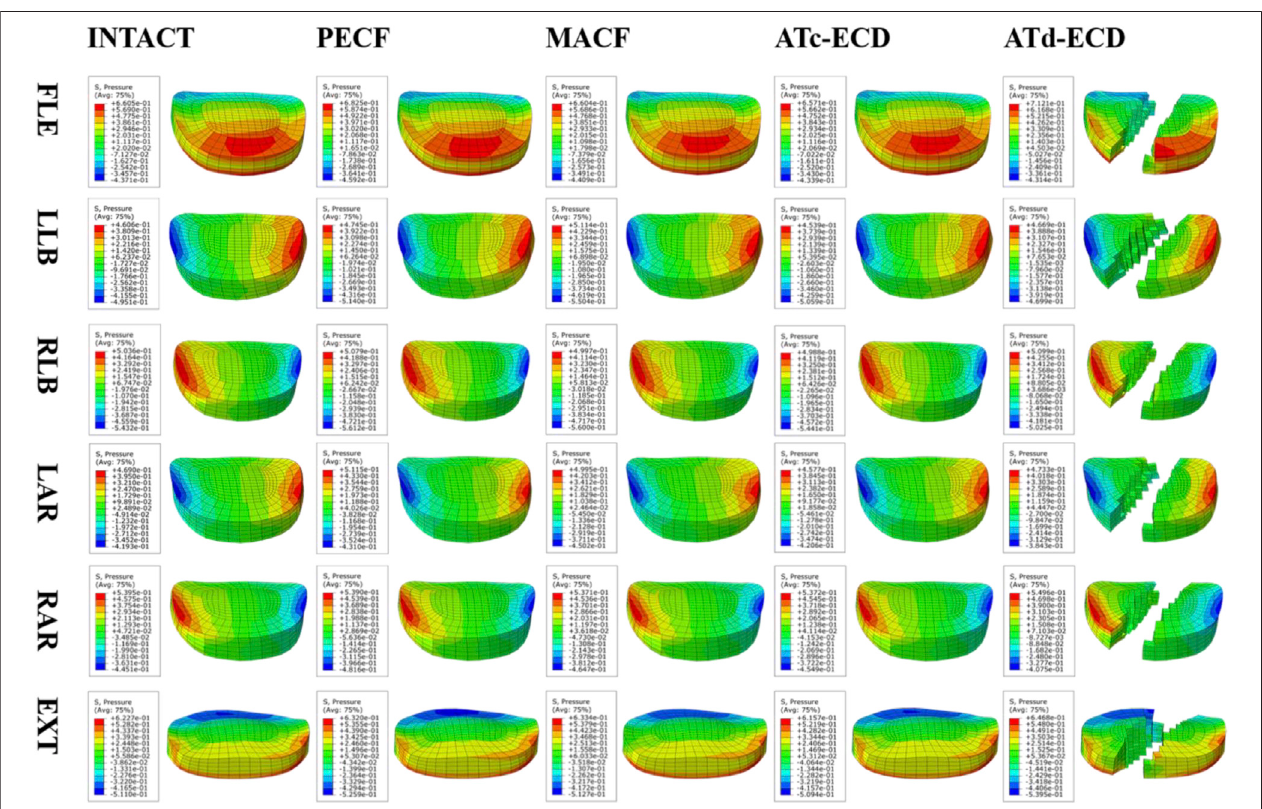
FIGURE5| Theintervertebraldiscpressurecontourplotsoftheoperatedsegmentduringdifferentmotions.FLE, fl exion;LLB,leftlateralbending;RLB,rightlateral bending; LAR, left axial rotation; RAR, right axial rotation; EXT, extension. The bottom of the fi gure describes the distribution of pressure of the posterior portion of the intervertebral disc in the contour plot of fl exion. In contrast, in the contour plot ofthe rest ofmotions, the bottom ofthe fi gure describes the distribution ofpressure ofthe anterior portion of the intervertebral disc in the contour plot of fl exion.